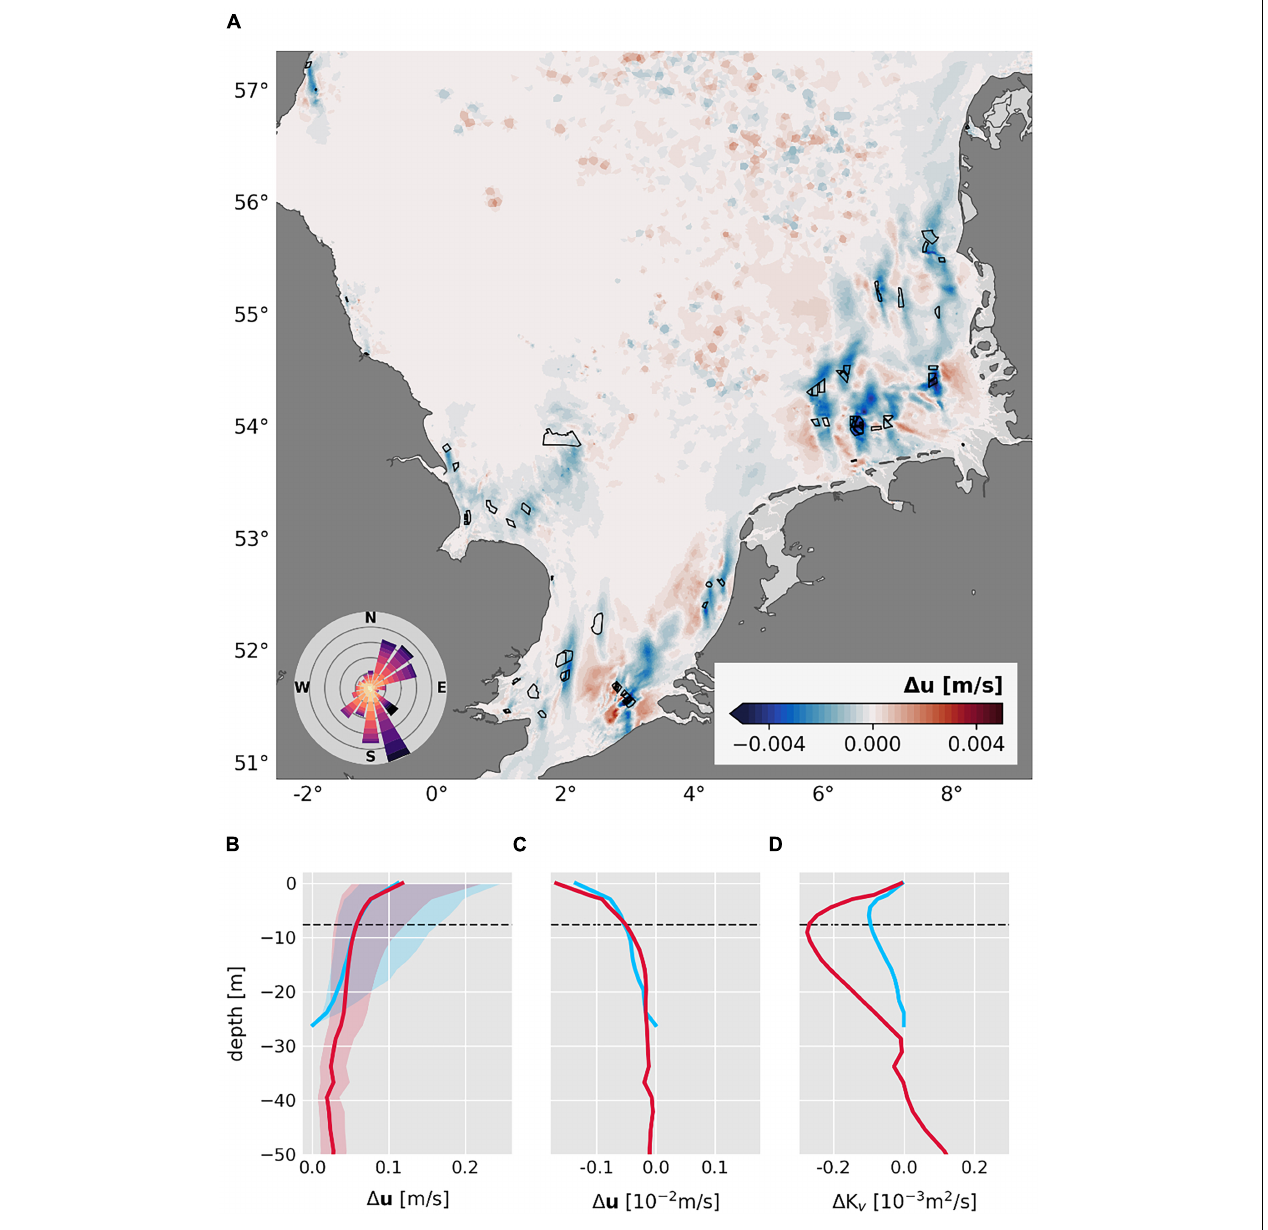
FIGURE 6 | Mean changes in horizontal velocity ( u ) and mixing rate ( K V ). (A) Mean changes in horizontal sea surface velocity for daily mean data in the month of May. Black polygons indicate offshore wind farms. The wind rose indicates the direction in which the wind blew (color range between 1 and 12 m/s). Mean vertical profiles for the mean horizontal velocity (B) , the mean changes in horizontal velocity (C) , and the mean changes in mixing rate (D) at wind farms for the month of May 2013. Filled envelopes in panel (B) demonstrate the temporal variability during May. Dashed lines indicate location of the mixed layer depth. For the profiles, grid points within 5 km around each wind farm were considered. Profiles are divided into deep ( z ≥ 25 m, red lines) and shallow ( z < 25 m, blue lines) water depths.